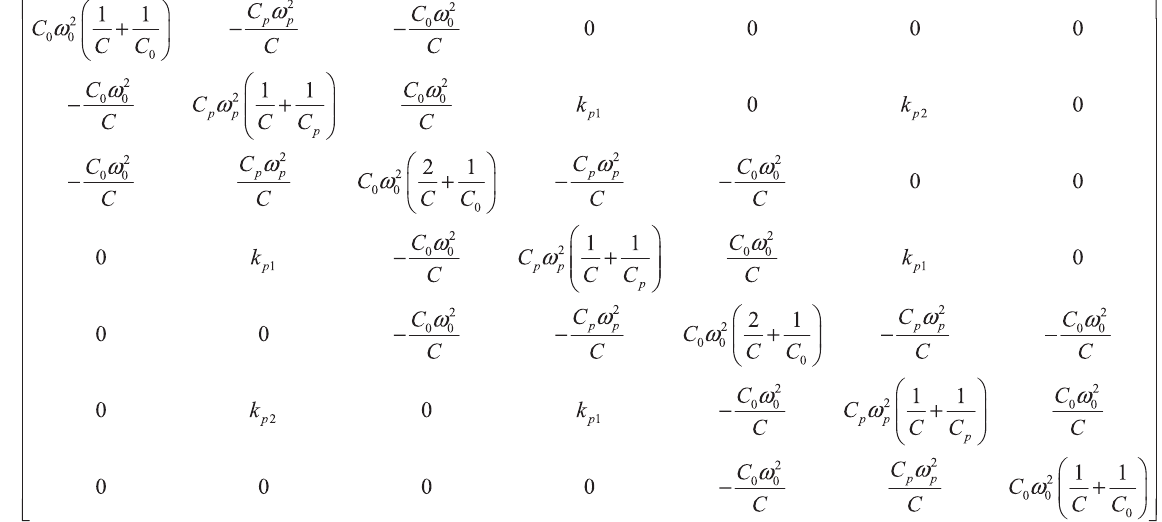
FIG. 21. Circuit matrix including nearest and next nearest coupling between